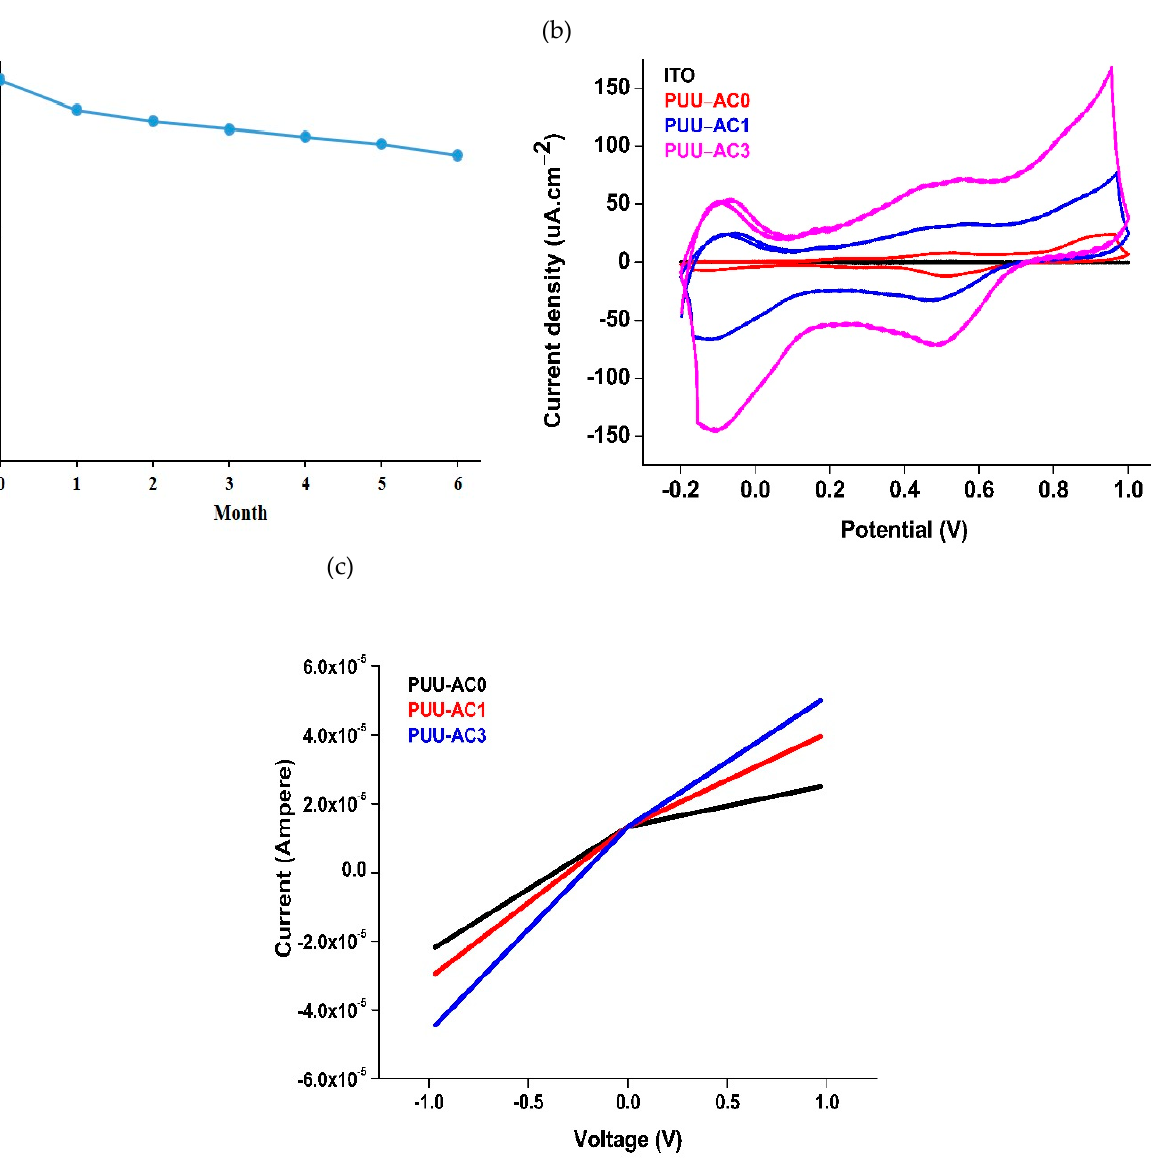
Figure 6. ( a ) Degradation profile of PUU-AC0 film in PBS (ph = 7.4) at 37 ◦ C ( b ) Cyclic voltammogram of blank ITO, PUU-AC0, PUU-AC1 and PUU-AC3 ( c ) Current-Voltage curves of PUU-ACO, PUU-AC1, PUU-AC3 sensors between − 1 V and + 1 V.